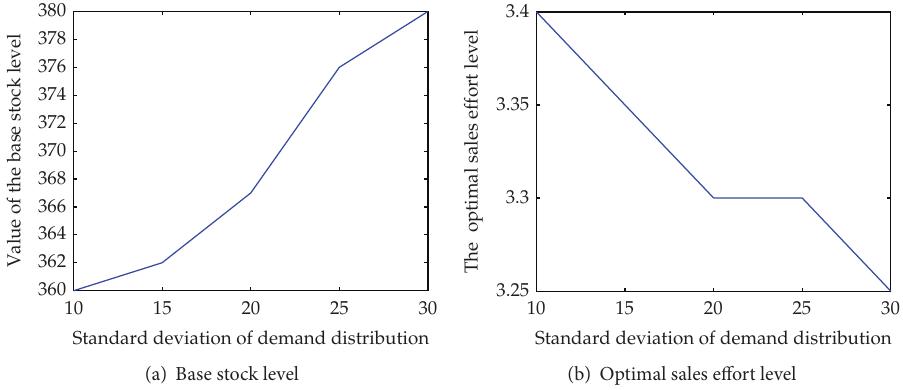
Figure 3: An illustration of the optimal policies with respect to demand